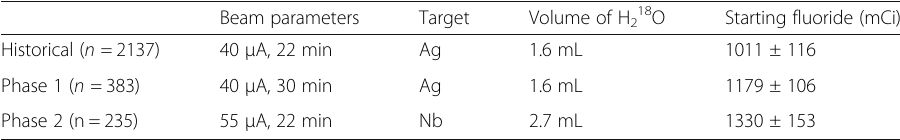
Table 1 Production of [ 18 F]fluoride on a PETtrace